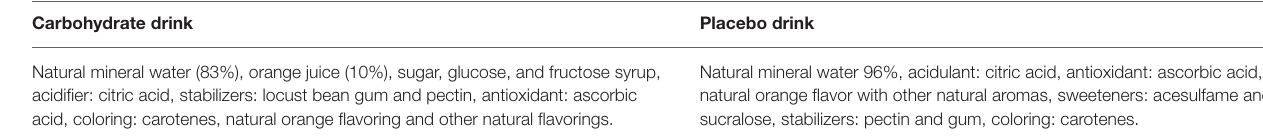
TABLE 1 | List of ingredients of the carbohydrate drink and the placebo drink. Carbohydrate drink Placebo